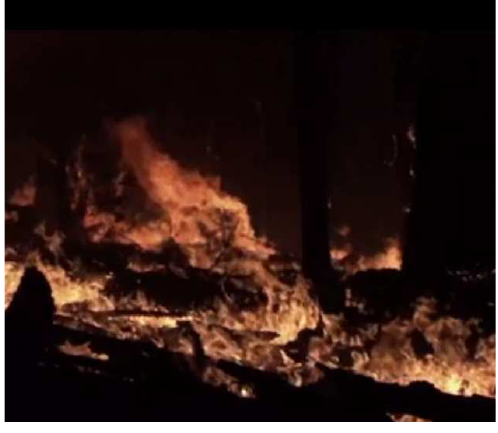
Figure 10. Initial crown fire.